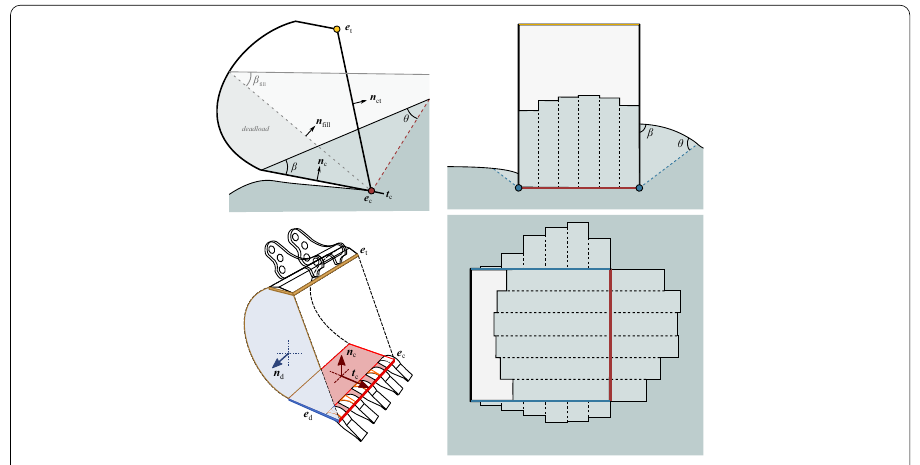
Fig. 4 The left images illustrate a digging tool with a cutting edge e c (red line), separating plate n c (red face), deformer edge e d (blue line), deformer face n d (blue face) and top edge e t (yellow line). The inner shape is indicated with the dashed lines. The normal n fill of the secondary separation plate range from n c to n ct depending on the fill ratio of the inner shape. The three active zones, discretized by vertical wedges, is illustrated from the rear (upper right) and from above (lower